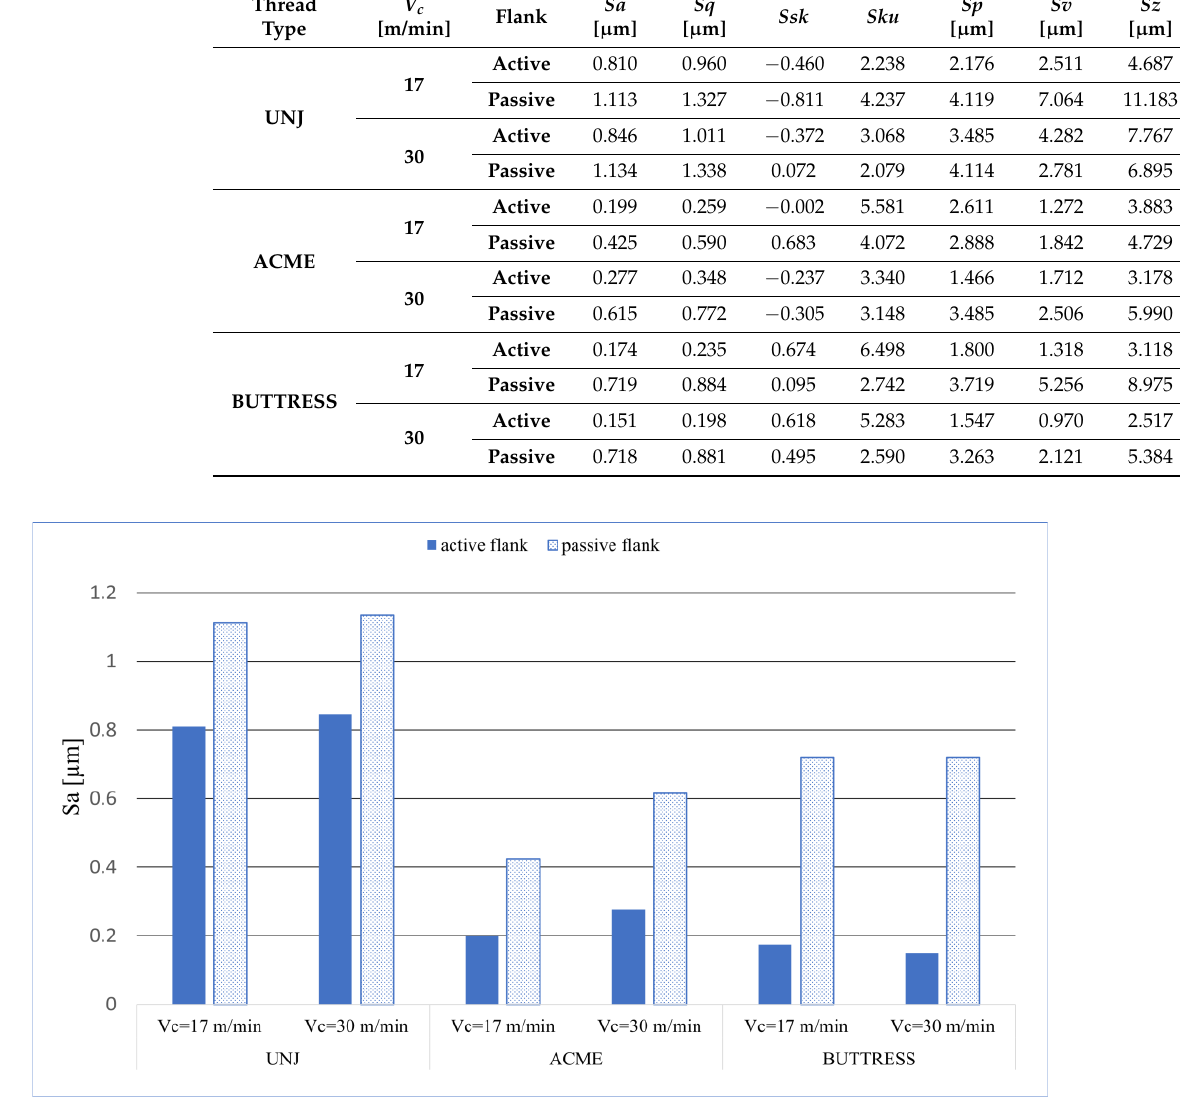
Figure 3. Sa values for the measured surfaces.